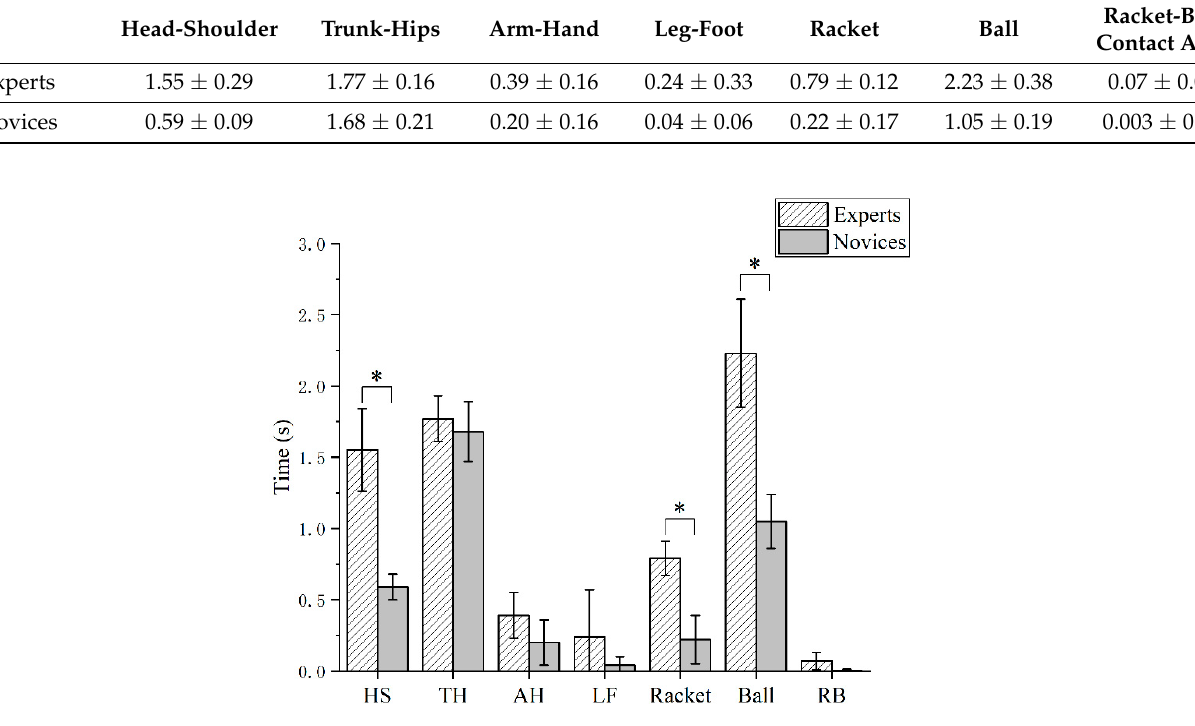
Figure 3. Gaze time for different positions during a forehand shot for tennis players of different skill levels. Gaze time for different positions during a backhand shot for different skill level tennis play- ers; HS: head–shoulder, TH: trunk–hips, AH: arm–hand, LF: leg–foot; RB: racket–ball. *: Statistically significant difference between experts and novices.